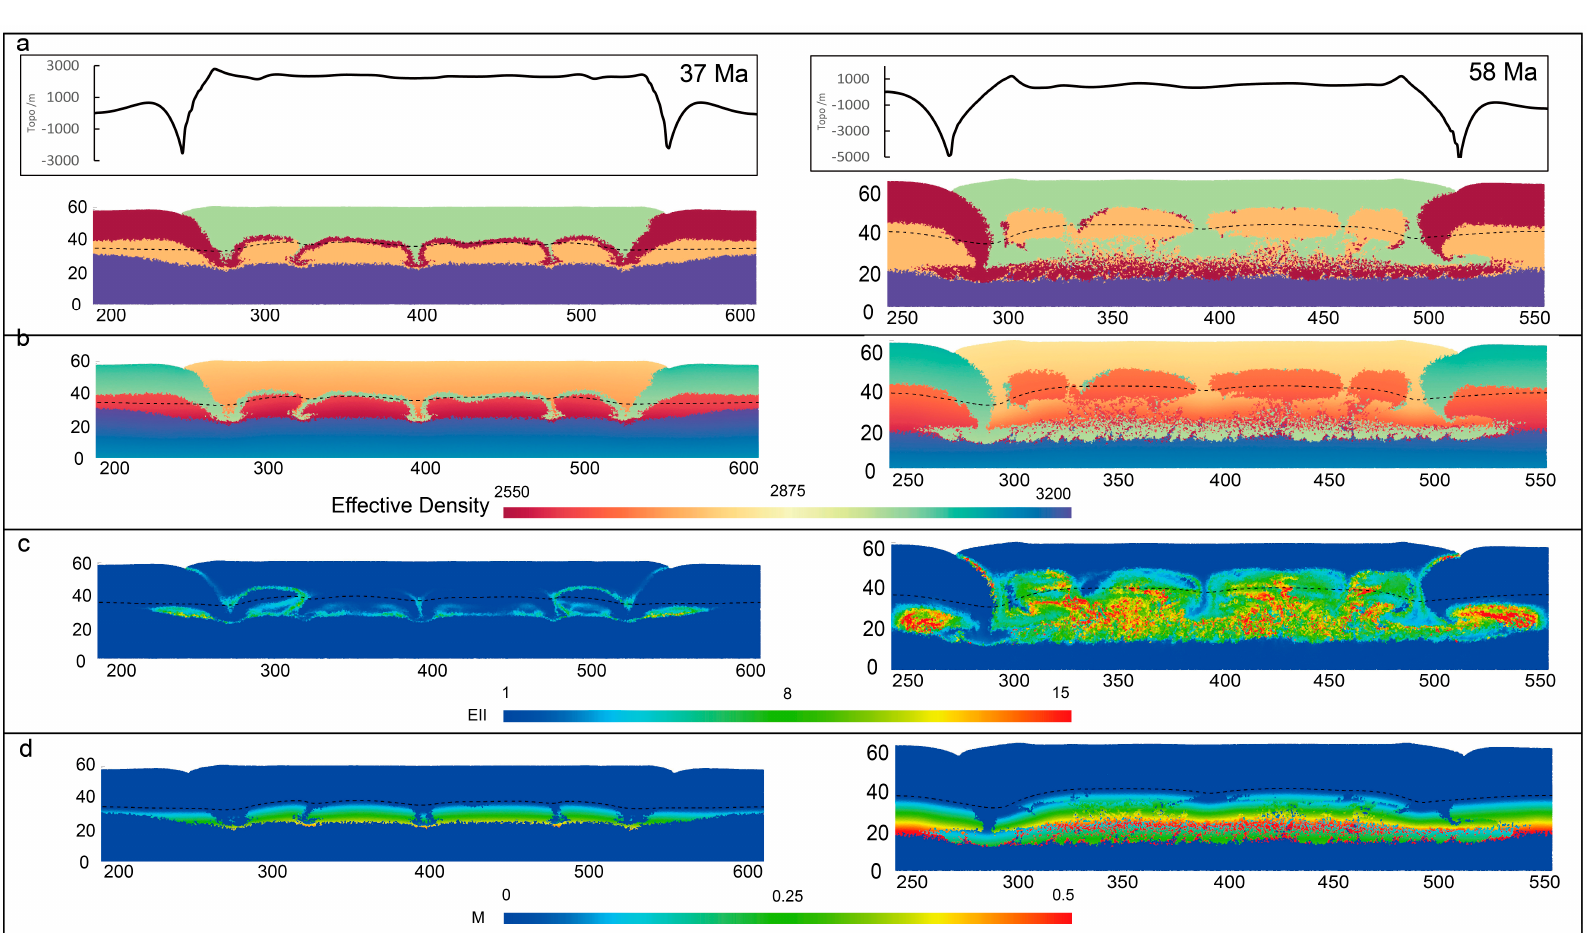
ε II · ∆ t ). ( d ) Melt fraction is obtained by 0